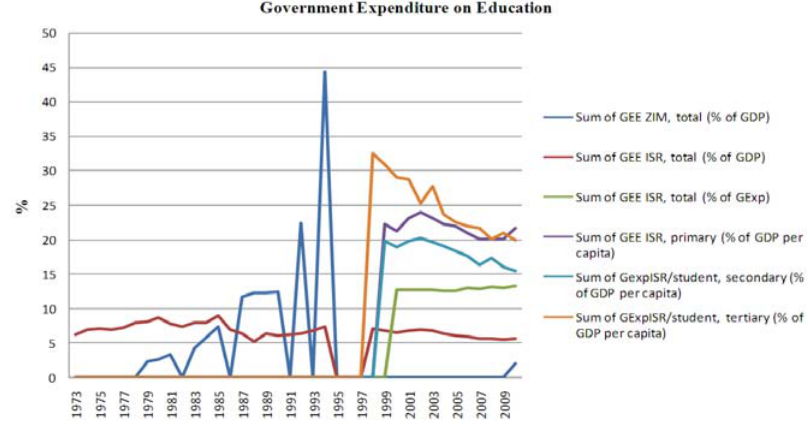
Fig. 2. Government expenditure on education